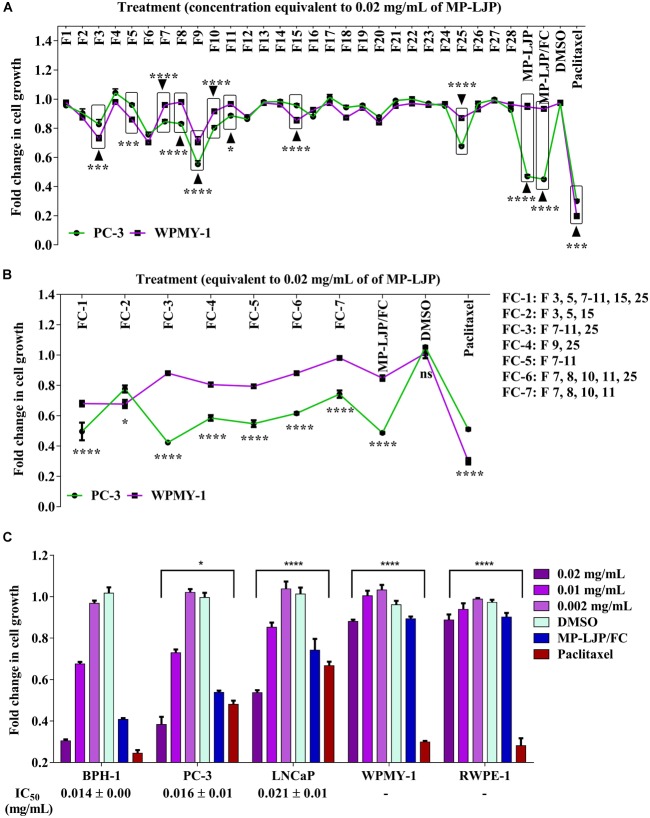
Anti-proliferative responses of MP-LJP sub-fractions after 72 h treatment on cancer cells and non-cancerous cells of prostate organ. CyQUANT NF proliferation assay was performed and the fold change in growth of fraction (FC)-treated cells with comparison vehicle (DMSO) treated cells was calculated. The data shown are mean ± SEM from three independent sets of three replicates. (A) Comparative responses of dried MP-LJP sub-fractions (F1–F28; 0.02 mg/mL), MP-LJP/FC and MP-LJP on PC-3 and WPMY-1 cells proliferation. (B) Anti-proliferative activity of sub-fraction in combination (F1: containing sub-fractions 3, 5, 7–11, 15, and 25; F2: sub-fractions 3, 5, and 15; F3: sub-fractions 7–11 and 25; F4: sub-fractions 9 and 25; F5: sub-fractions 7–11; F6: sub-fractions 7, 8, 10, 11, and 25; and F7: sub-fractions 7, 8, 10, and 11) on PC-3 cells with comparison to WPMY-1 cells. (C) Dose proliferation response of FC-3 after 72 h treatment of BPH-1, PC-3, LNCaP, PC-3, WPMY-1, and RWPE-1 cells. Non-linear regression analysis with variable slope was performed to determine IC50 values. Statistical analyses used two-way ANOVA followed by Bonferroni multiple comparison test with ∗p < 0.05, ∗∗p < 0.01, ∗∗∗p < 0.001, and ∗∗∗∗p < 0.0001, statistically different from vehicle treated cells.